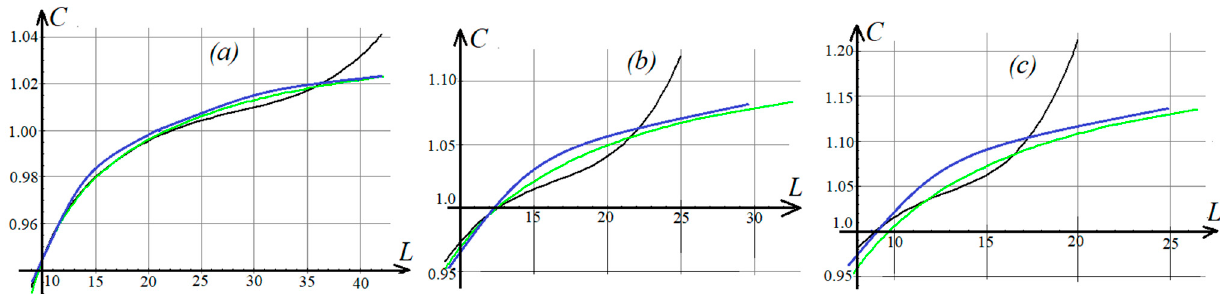
Figure 2. Dependence of the phase velocity C of waves on the length L for various wave heights: ( a ) H = 0.1, ( b ) H = 0.3 and ( c ) H = 0.5. The green, blue and black lines correspond to the FN, iFN and SW models, respectively.